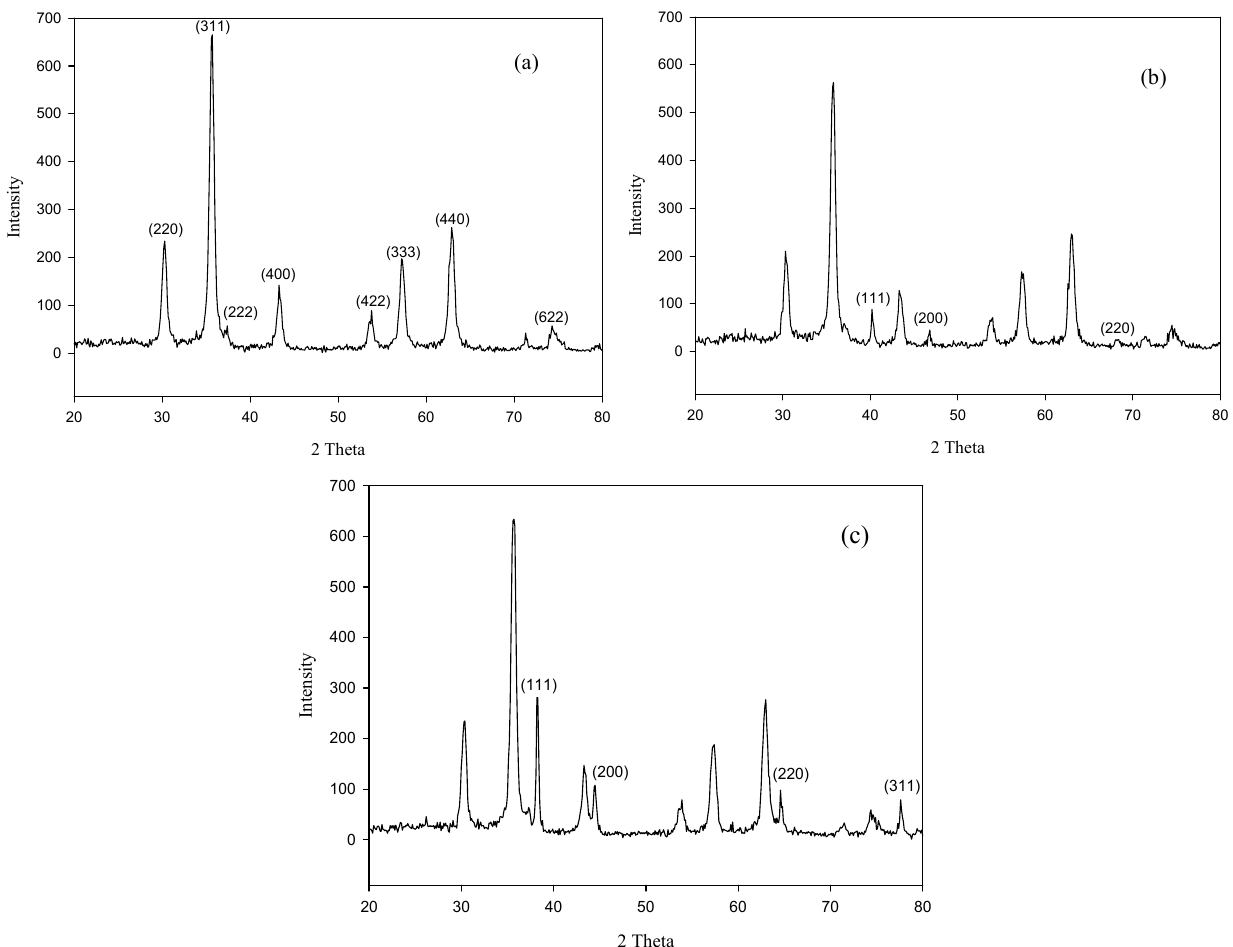
Figure 2. XRD patterns of ( a ) MNP-Tu, ( b ) Pd(II)-loaded MNP-Tu and ( c ) Au(III)-loaded